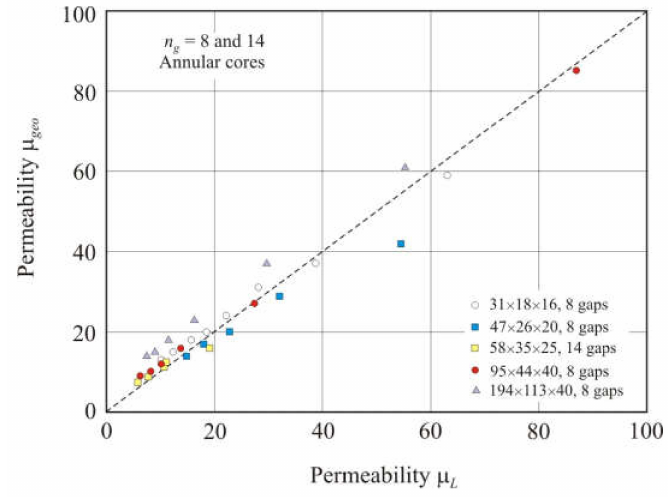
Figure 14. Relationship between geometric permeability µ geo and measured permeability µ L in nanocrystalline annular cores with 8 or 14 air gaps. The total air gap length l g was taken equal to ( l s + l o ), where l s is the spacer thickness, and l o is the residual air gap length. The dashed line corresponds to equation µ geo = µ L